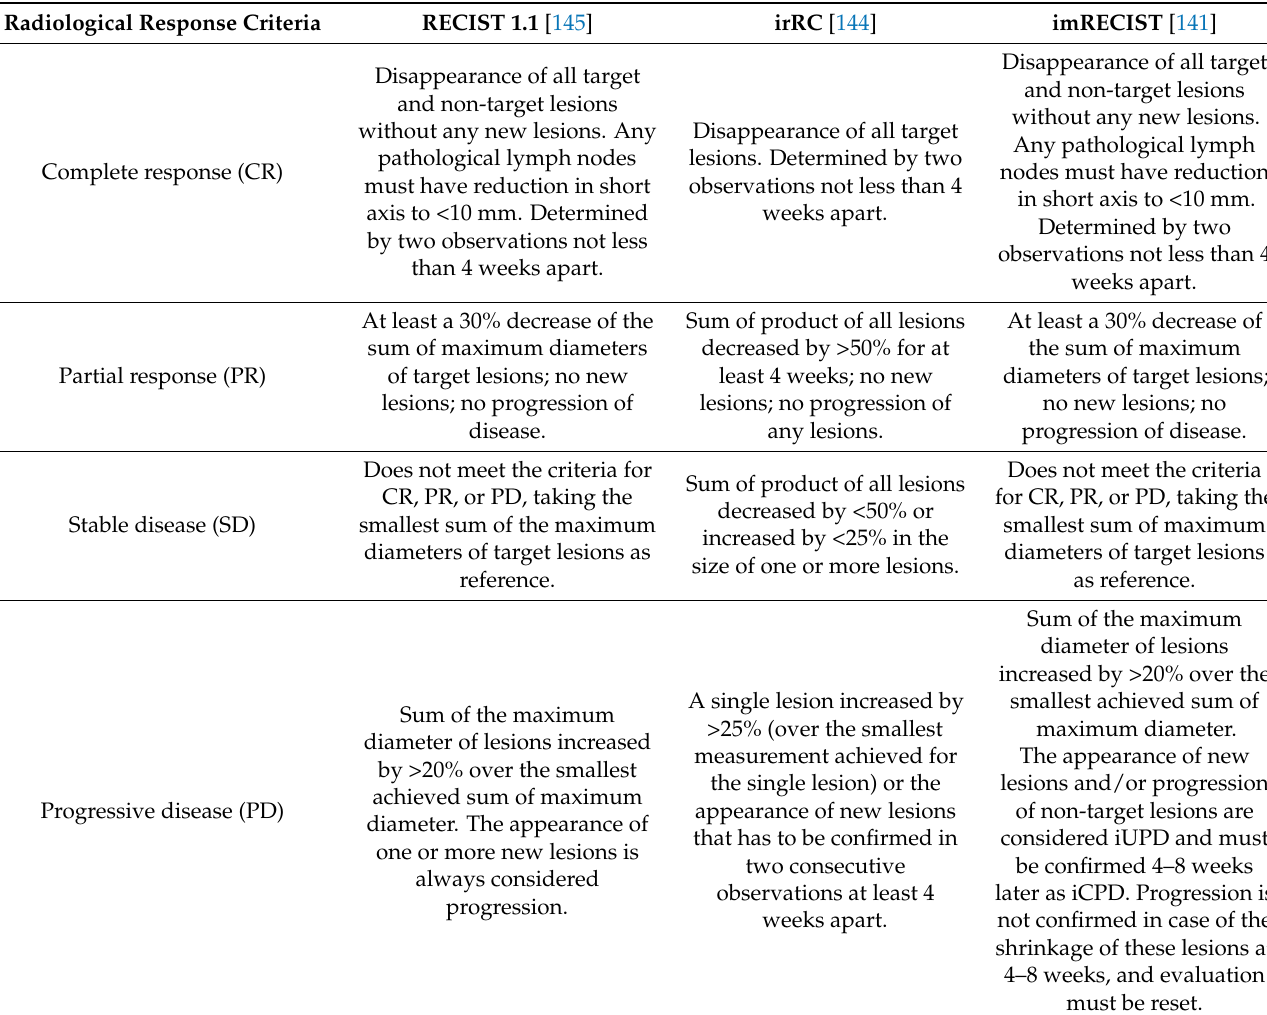
Table 2. Summary of the radiological and functional immunotherapy-modified response criteria (irRC, imRECIST, imPER- CIST, PERCIMT) to the immunotherapy in tumor compared with the non-immunotherapy-specific ones (RECIST 1.1 and